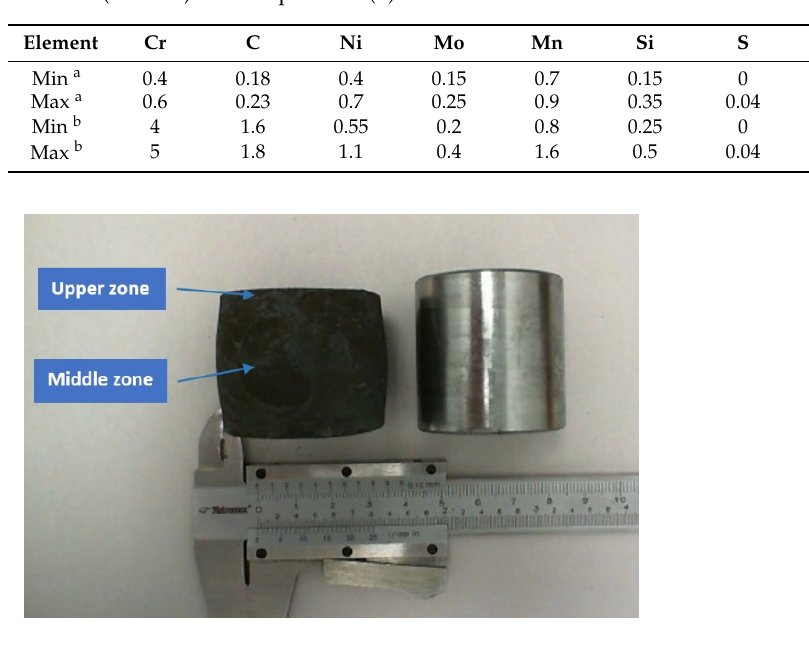
Figure 1. Deformed steel bar: initial diameter, 38.1 mm; initial height, 44 mm; final height, 40 mm.